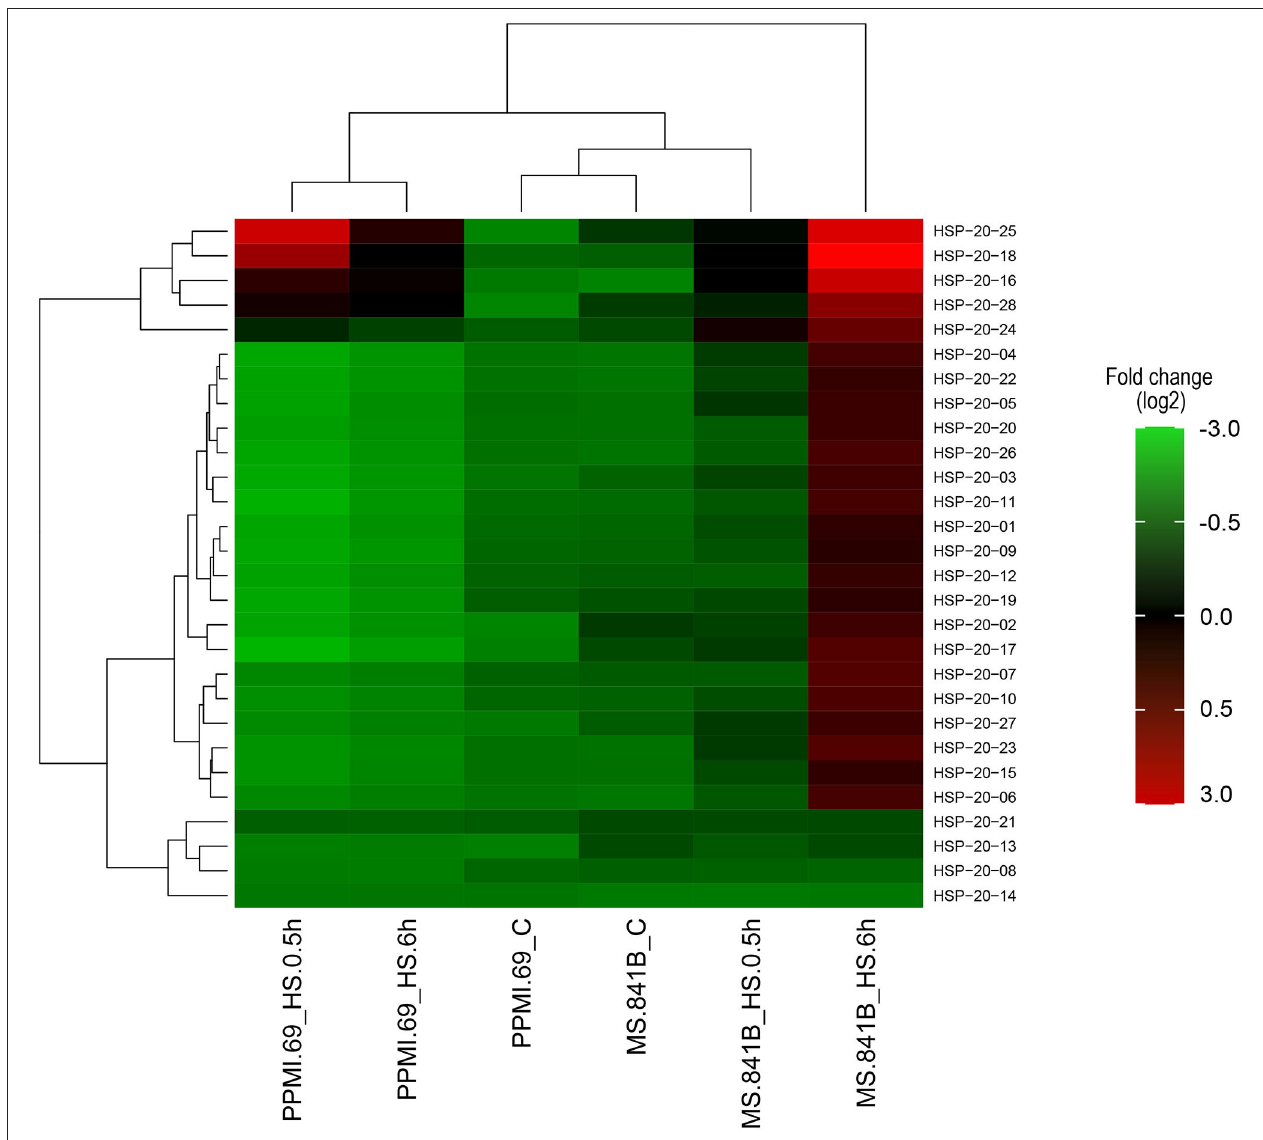
FIGURE 9 | The expression heat map of 28 pearl millet HSP20 genes under heat stresses based on the RNA-sequencing (RNA-Seq) data. The heat map with clustering was created by using a log2-based Fragments Per Kilobase of transcript per Million mapped reads (FPKM) value. On the right side of the heat map with a color scale representing relative expression values. C, control plants were maintained at 25 ◦ C; HS, heat stress of 42 ◦ C for 0.5 and 6h, respectively, was imposed on plants maintained in the growth chamber (https://figshare.com/s/7132de92e289274bc8e1).